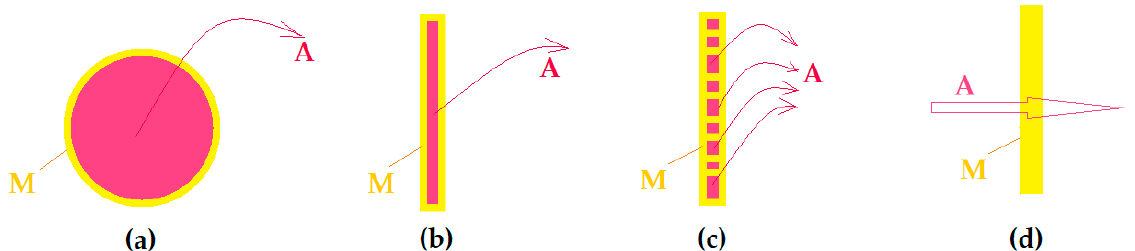
Figure 1. Schematic representation of releasing of an active species (A): from ( a – c ); or through ( d ); a membrane (M).